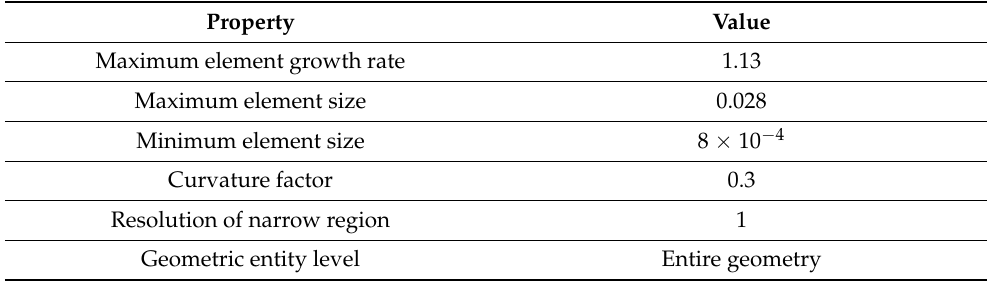
Table 3. A description of the mesh sizes.